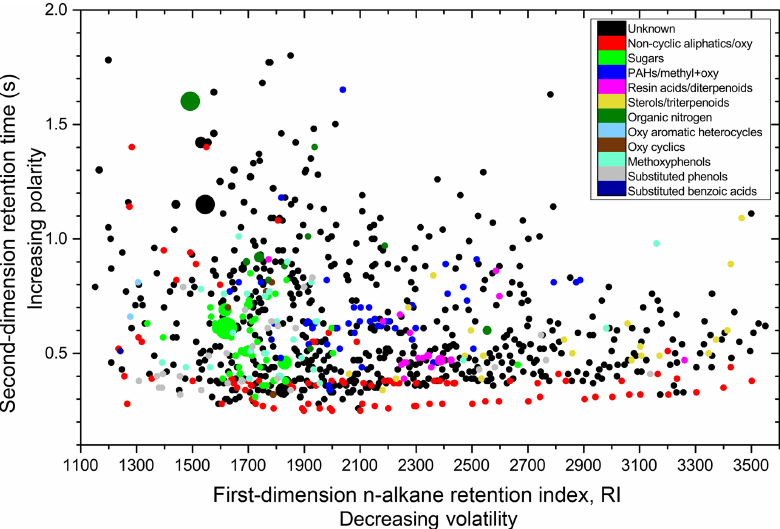
Figure 2. Two-dimensional chromatogram of smoke collected from burning lodgepole pine (burn 63). The first dimension separates com- pounds by their volatility and the second dimension by their polarity. Each point ( ∼ 800 in total) represents a separated compound with the colors signifying the compound’s classification. Size of a point approximately scales with its emission factor (see Sect.